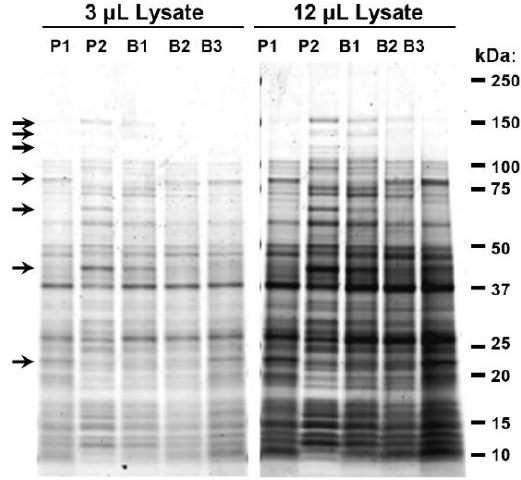
Figure 1. Analysis of proteins from A. baumannii cultures grown under varying conditions.